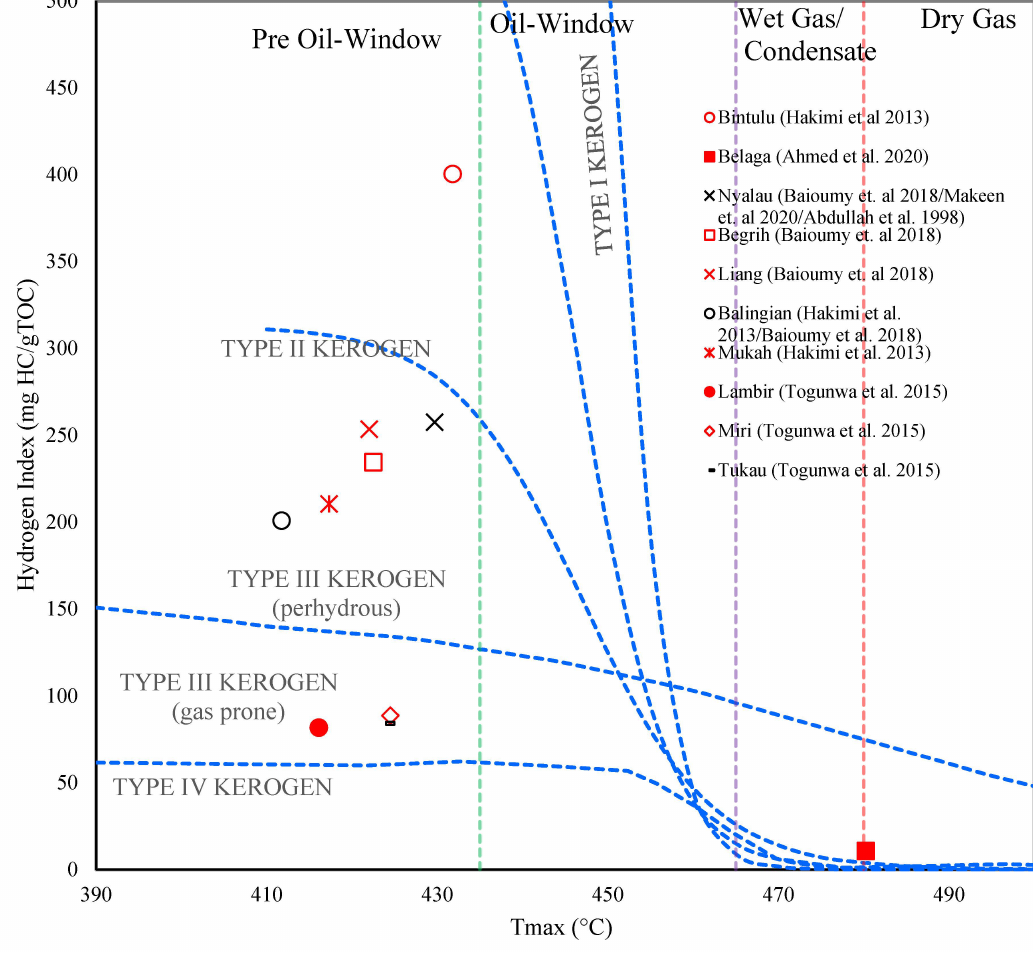
Figure 17. Tmax vs. HI plot kerogen maturity level of formations in